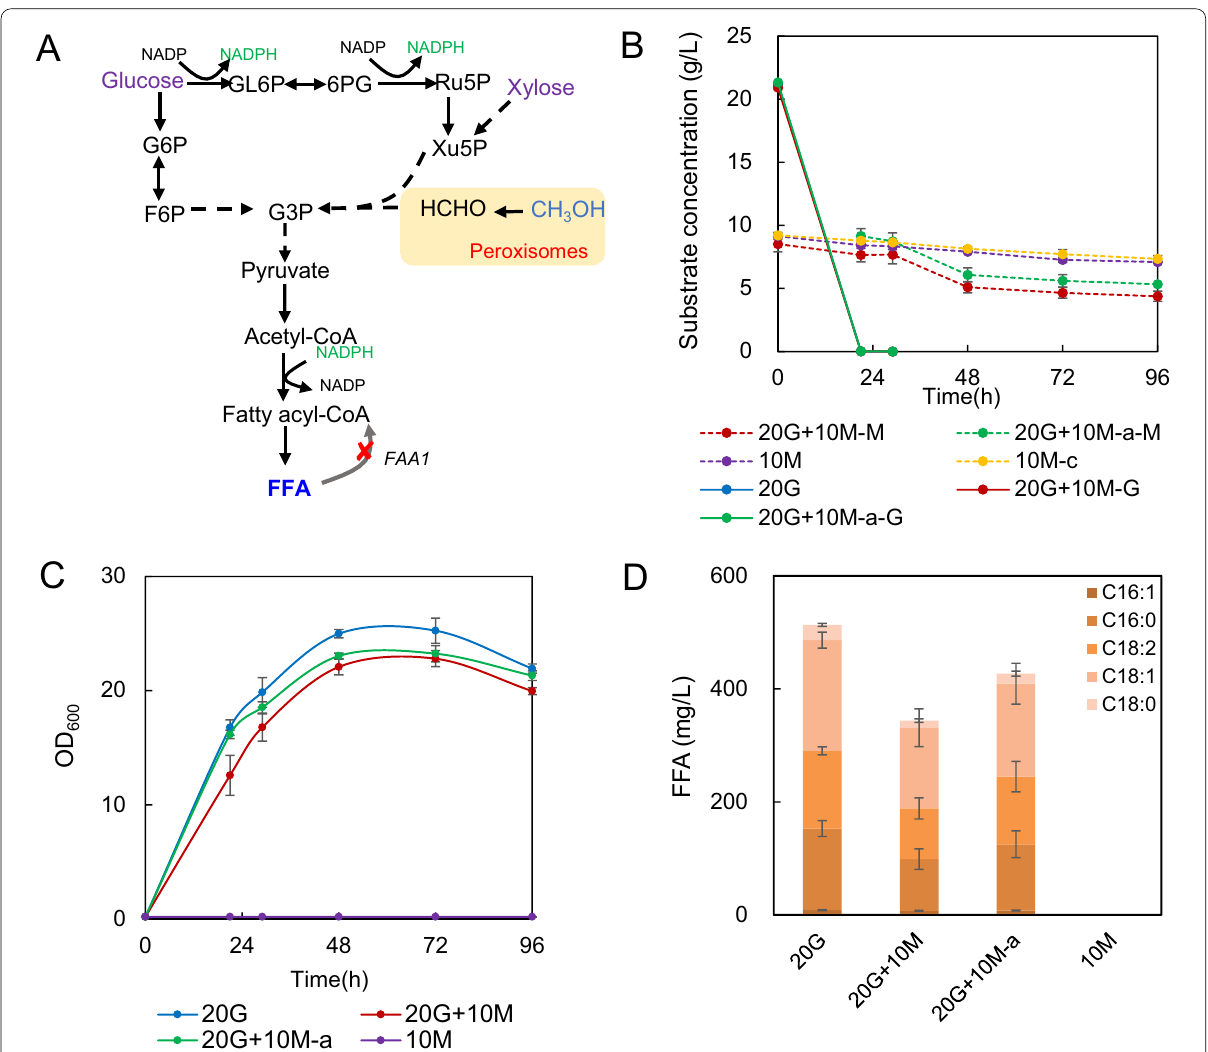
Fig. 4 Co-feed of glucose and methanol for FFA production in strain FD09. A Schematic diagram of glucose and methanol metabolism in O. polymorpha . Supplemented glucose will provide extra NADPH for both cell growth and FFA production. B Concentration of carbon sources (-M: methanol concentration, -G: glucose concentration, 10 M-c: control of methanol volatilization without inoculation) in different carbon sources. 20G: 20 g/L glucose, 10 M: 10 g/L methanol, 20G 10 M: 20 g/L glucose and 10 g/L methanol, 20G 10 M-a: 20 g/L glucose with 10 g/L methanol + + supplemented at 24 h. C Growth curve of FD09 in different carbon sources. D FFA titer of FD09 in different carbon sources. All strains were cultivated in minimal medium with the specific substrates. Data are presented as mean s.e.m. (n 3 biologically independent ± =